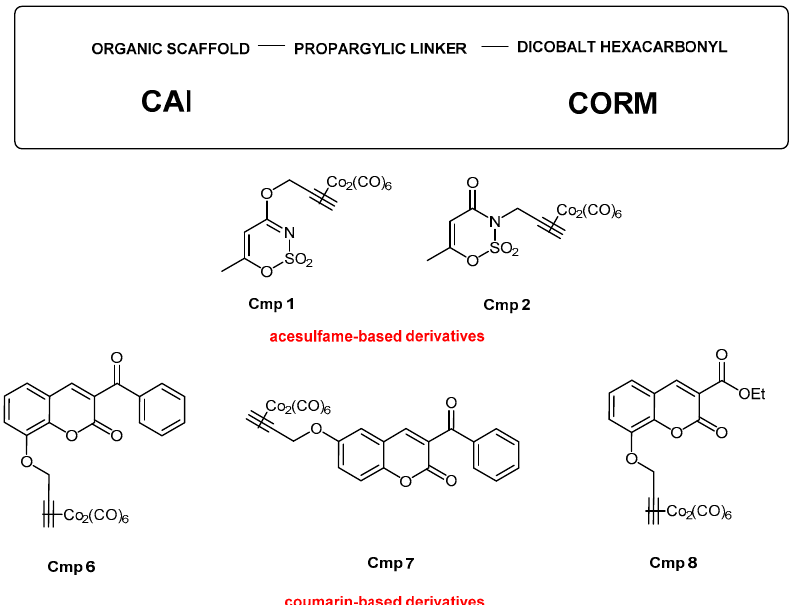
Figure 1. Structures and chemical scaffolds of the five dual carbonic anhydrase inhibitor-carbon monoxide releasing molecule (CAI-CORM) hybrids selected for this study.